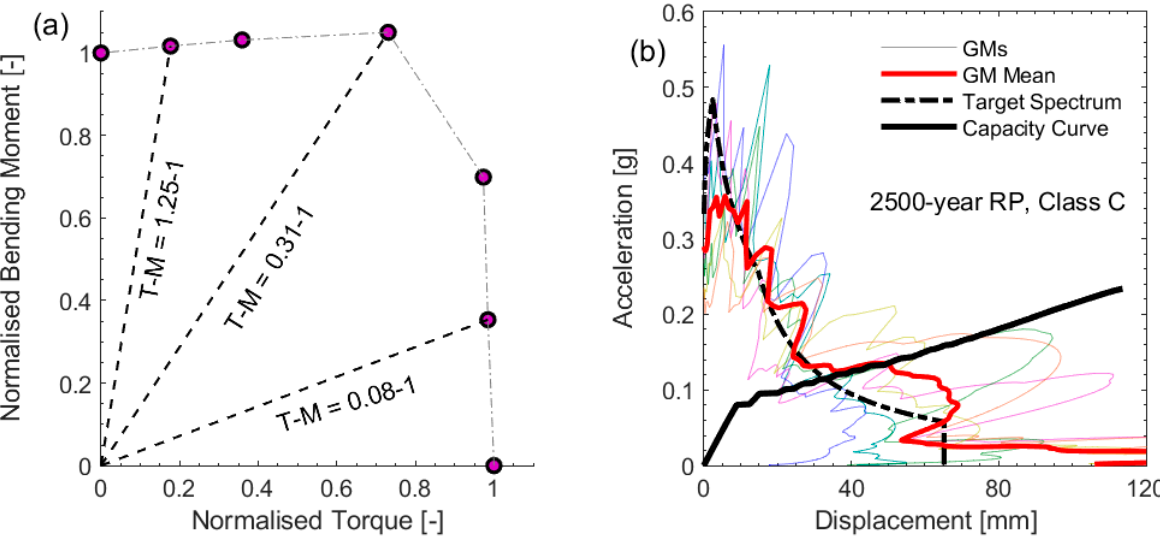
Figure 8. ( a ) Normalized maximum bending moment (M) and torque (T) relationship using the last converged point (corresponding to peak strength) of the different nonlinear pushover analyses performed; ( b ) the capacity spectrum method using inelastic spectra is applied to the pushover result for the wall with T-M = 0.31–1, comparing it to the acceleration-displacement inelastic response spectra corresponding to an event with a 2500-year return period in Melbourne on site class C.